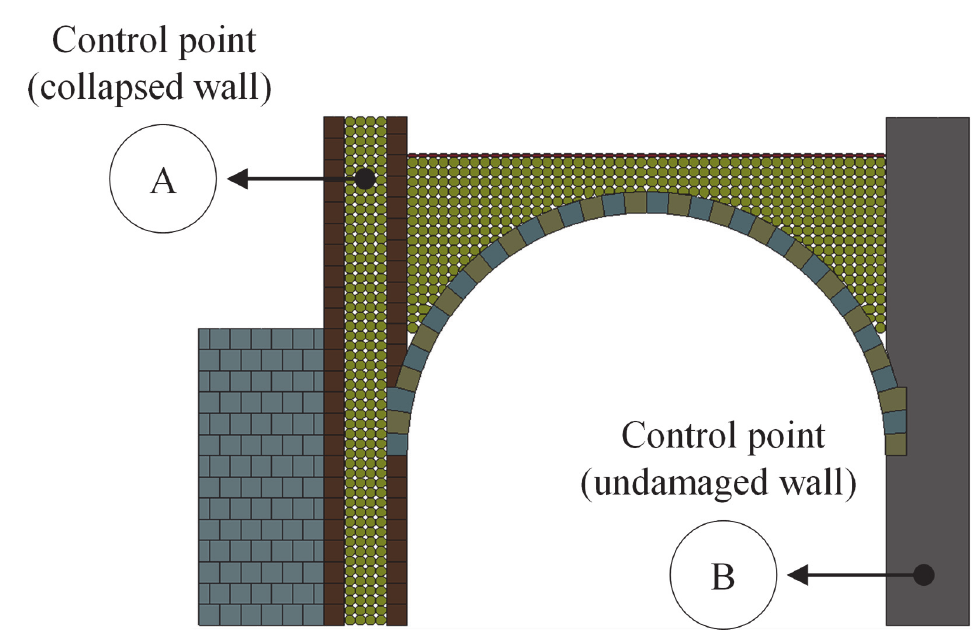
Figure 8: Control points for the force time-histories: A, in the collapsed wall, and, B, in the undamaged wall Fig. 9 refers to the left wall, adjacent to the contrasting block that is demolished, and which is the one that collapsed. The graph shows the vertical stress (force) at one point in the wall (A in Fig. 8). Reference is made to the second scenario (L equal to 7.1 meters). In the first 10 seconds the loading phase takes place. From 10 to 15 seconds the attenuation of the free oscillations is observed. In addition, some disturbance can also be observed due to the change of constrains. At 15 seconds, the contrasting block is demolished and the collapse initiates. At this point, the vertical force diminishes rapidly.